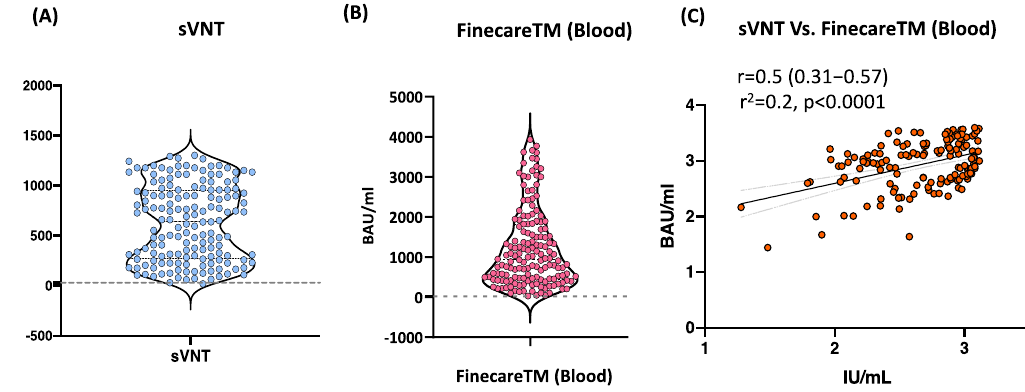
Figure 2. ( A ) Point distribution of sVNT. ( B ) Point distribution of FinecareTM. ( C ) Correlation and linear regression analysis between FinecareTM and the surrogate virus neutralization test (sVNT). Pearson correlation coefficient ( r ), coefficient of determination (R 2 ) , and p -value are shown; n = 156.